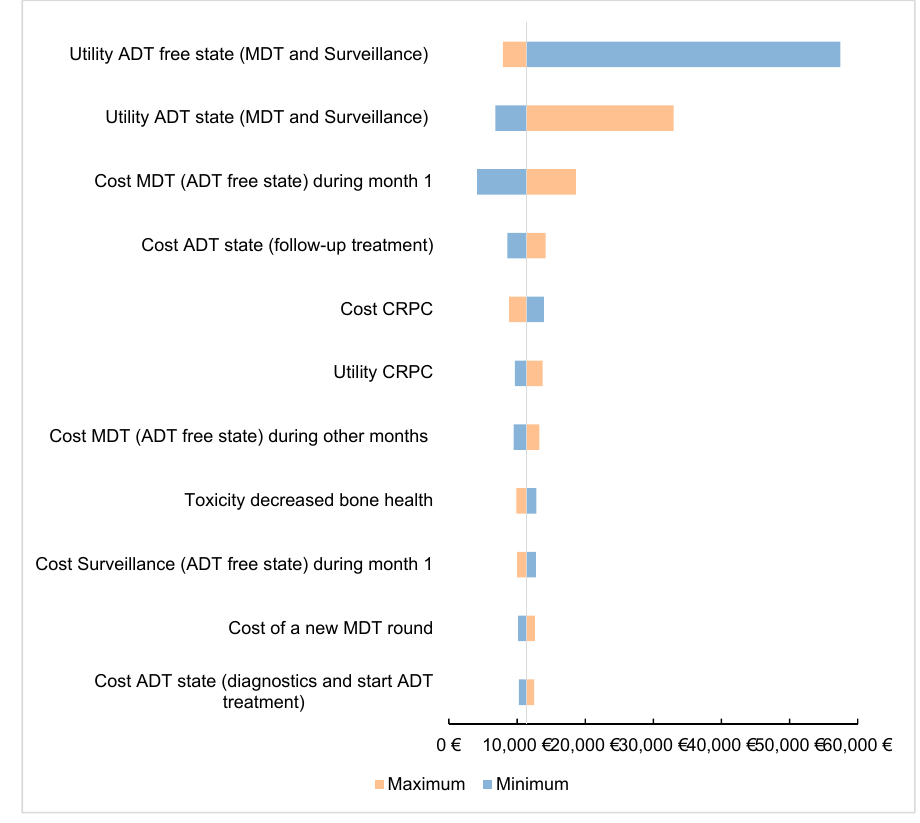
Figure 4. One-way sensitivity analysis - tornado diagram. Tornado model showing the impact of the different variables on the ICER. In this figure, all sensitivity scores were set at 100%. The figure depicts the impact on the ICER when the sensitivity score ranges from 80% to 120%. ADT: Androgen-deprivation therapy; MDT: Metastasis-directed therapy.